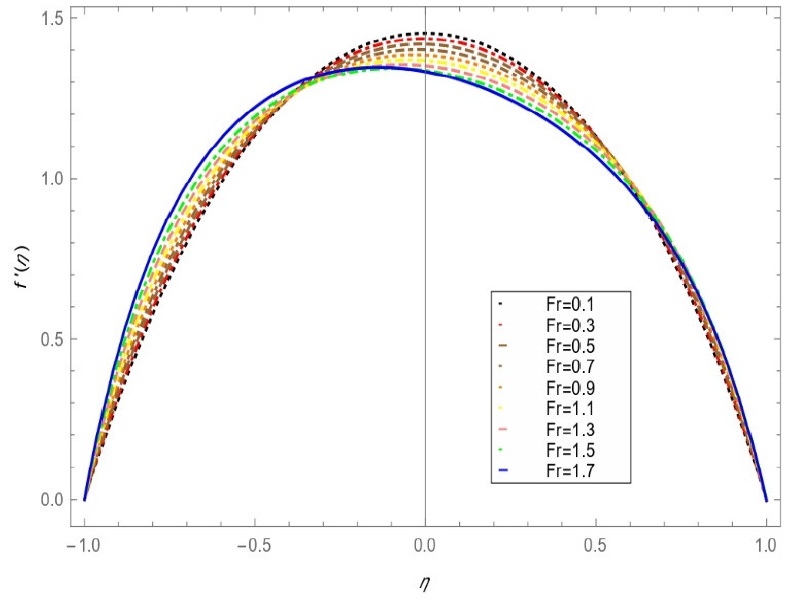
Figure 5. Radial velocity profile effect of the Forchheimer number for α = 2, Re = 1, ϕ 1 = ϕ 2 = 0.01, dp 1 = dp 2 = 10, M = 2, β = 1.